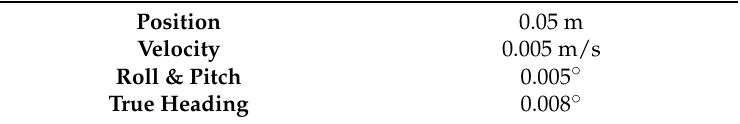
Table 2. Absolute Accuracy Specifications (RMS) of the upgraded IMU